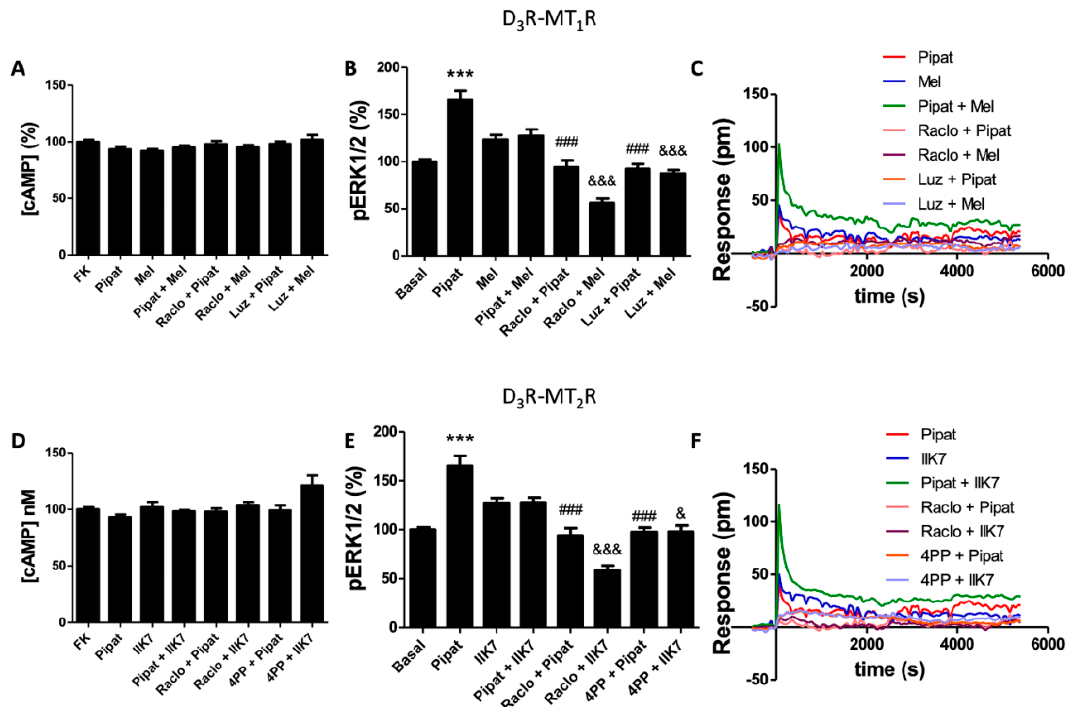
Figure 4. Effect of dopamine and melatonin receptor agonists in human 59HCE cells. Signaling was assayed in the 59HCE cells pre-treated with antagonists (1 μ M raclopride for D 3 R, 1 μ M luzindole for MT 1 R, or 1 μ M 4PPDOT for MT 2 R) or vehicle, and then subsequently treated with agonists (100 nM 7-OH-PIPAT for D 3 R and either 1 μ M melatonin for MT 1 R ( A – C ) or 300 nM IIK7 for MT 2 R ( D – F )), individually or in combination. ( A , D ) cAMP production is expressed as % over 0.5 μ M forskolin-induced [cAMP] increases. ( B , E ) ERK1/2 phosphorylation data are expressed as % with respect to basal levels. In cAMP accumulation and MAPK signaling assays, the values are the mean ± S.E.M. of 5 different experiments performed in triplicates, and one-way ANOVA followed by Bonferroni’s multiple comparison post-hoc tests were used for statistical analysis. (*** p < 0.001; versus basal in pERK assays). (### p < 0.001; versus treatment with 7-OH-PIPAT alone). (& p < 0.05, &&& p < 0.001; versus treatment with melatonin or IIK7 alone). ( C , F ) DMR tracings representing the picometer-shifts of reflected light wavelengths over time upon ligand treatment. Note that data related to D 3 R agonists are the same in the upper and lower panels; for clarity, we decided to keep six panels instead of including all the information in three panels.